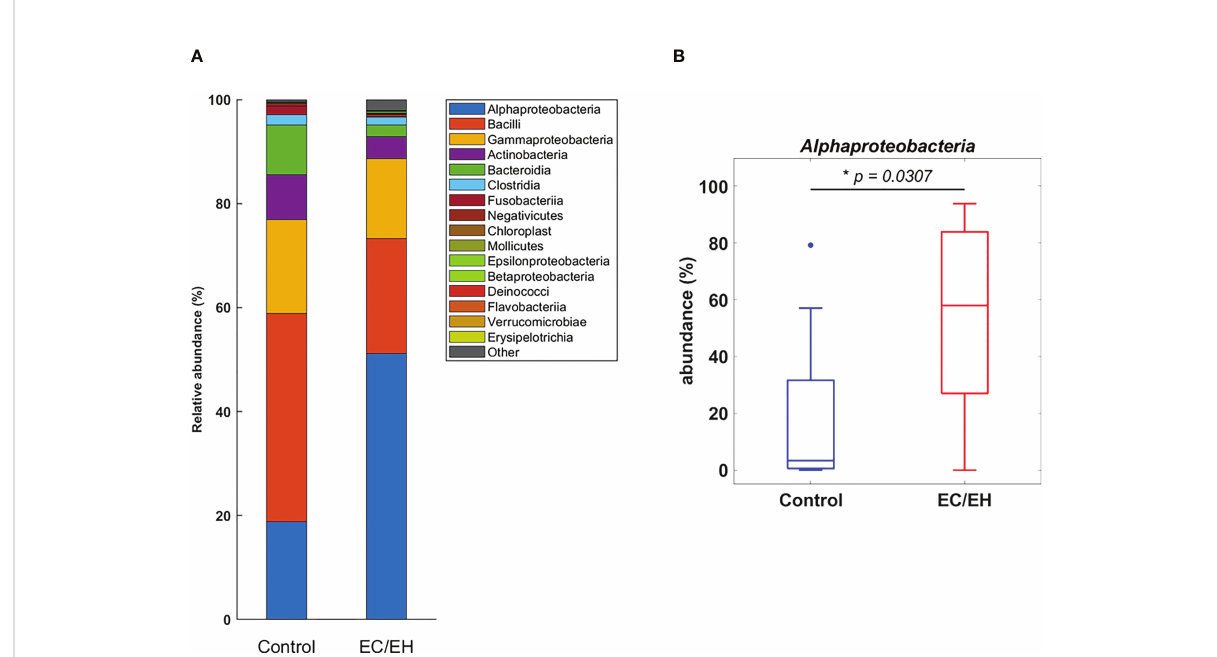
FIGURE 2 (A) Relative abundance of endometrial lavage bacteria in patients with EC/EH versus control women: taxonomic identi fi cation at the class level. (B) Box plots revealed a statistically signi fi cant intergroup difference in the relative abundance of the Alphaproteobacteria class. “ * ” means statistically signi fi cant